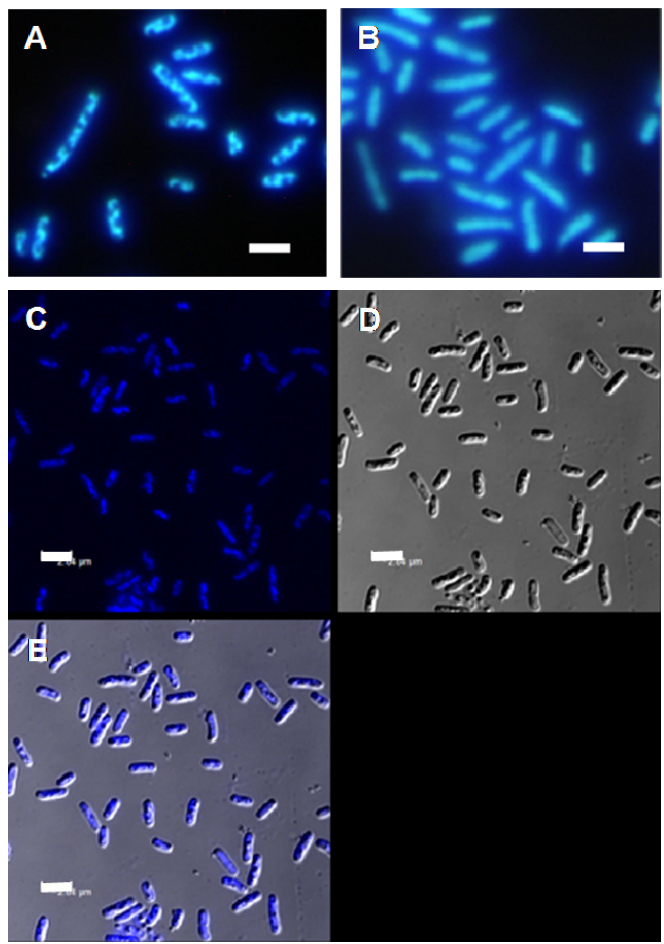
Figure 5. Fluorescence microscopy and confocal laser scanning microscopy images of DAPI-stained E. coli . ( A ) Over-expressed HCcp3 in E. coli ; ( B ) The control E. coli without HCcp3 expression; ( C – E ) Over-expressed HCcp3 in E. coli observed using a Confocal Laser Scanning microscope; ( C ) fluorescent image of DAPI-stained E. coli ; ( D ) Bright field image of DAPI-stained E. coli ; ( E ) the merged images of ( C ) and ( D ). Scale bar: 2